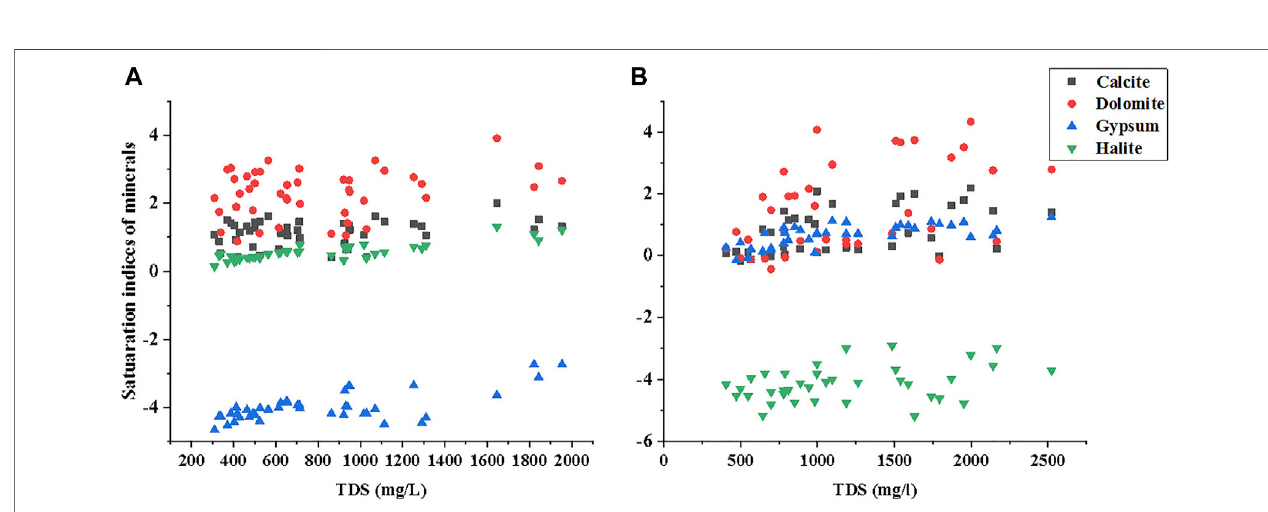
FIGURE 3 | Saturation indices of Calcite, Dolomite, Gypsum, and Halite against TDS in the study area of (A) Ghotki and (B) Nawab Shah.